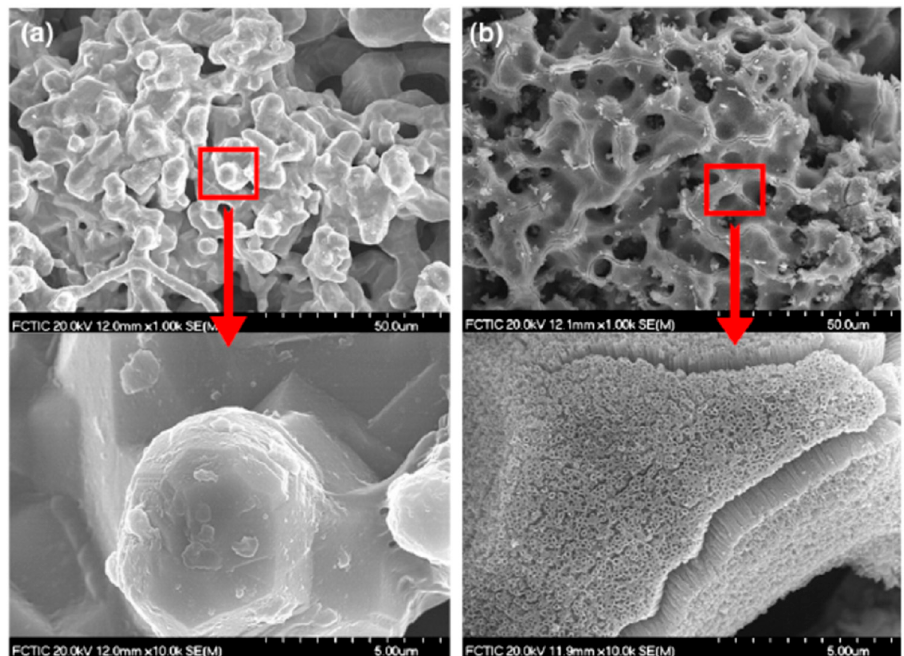
Figure 9. FE-SEM measurements on ( a ) an original Ti membrane filter and ( b ) an anodised TiO 2 membrane (the diameter of nanotubes exceeded the range of 25–75 nm and a wall thickness of ~15–20 nm). Reprinted from “Fabrication and photocatalytic activity of a novel nanostructured TiO 2 metal membrane” [130], © 2011, with permission from Elsevier.